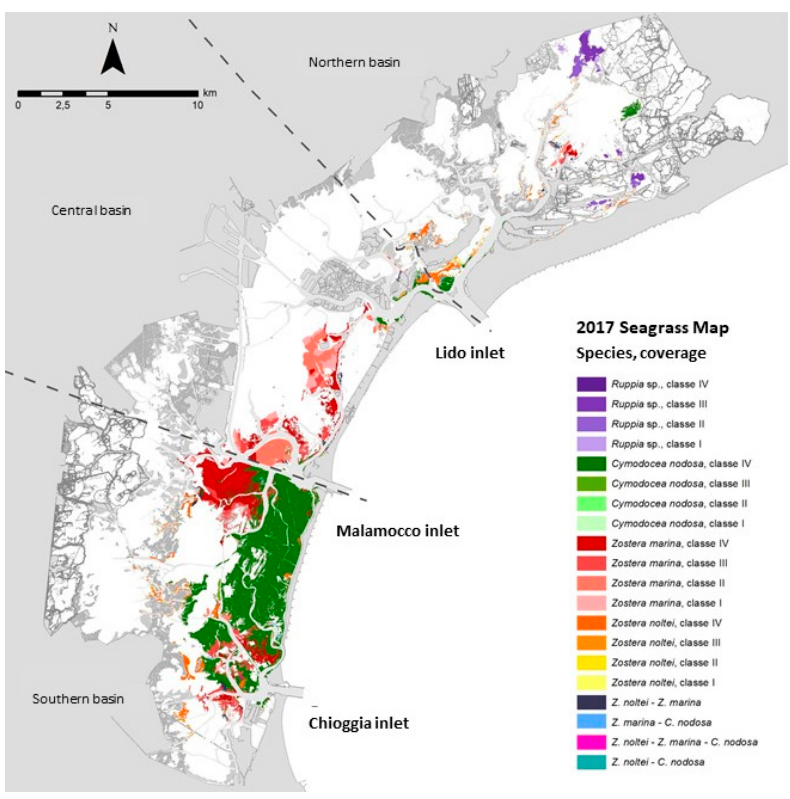
Figure 1. Marine seagrass distribution for Venice lagoon (2017 map) [38].